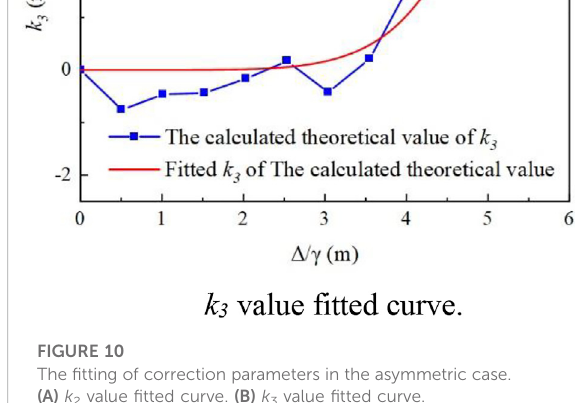
FIGURE 10 The fi tting of correction parameters in the asymmetric